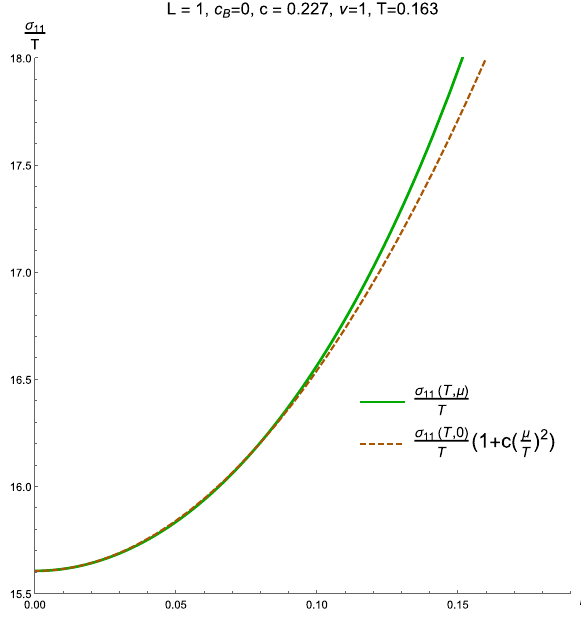
Fig. 5 The dependence of σ 11 / T on the chemical potential μ for tem- perature T = 0 . 163 corresponding to the Hawking–Page phase tran- sition. The green curve represents the exact answer, the dashed brown curve is the power series in μ around μ = 0